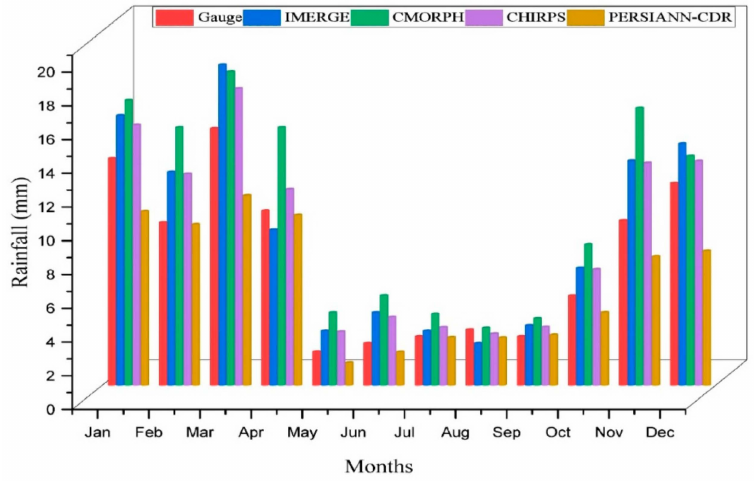
Figure 5. Mean monthly rainfall for gauge and remote sensing